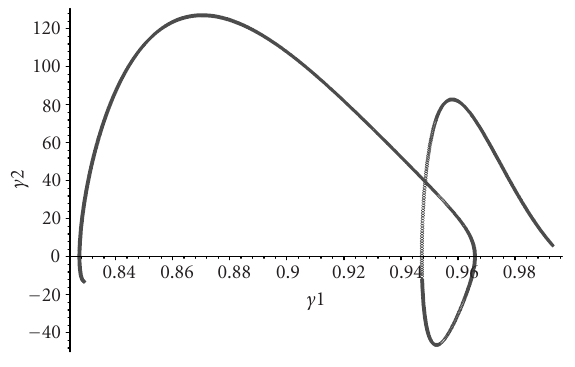
Figure 5.6. ˙ ε , ε plane in the τ interval represented in Figure 5.2.